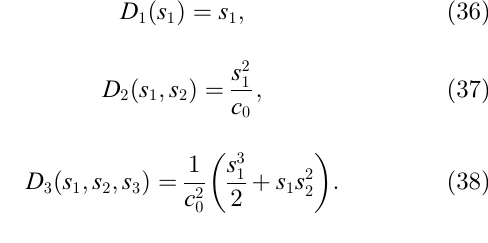
D H , D H . This 1 2 3